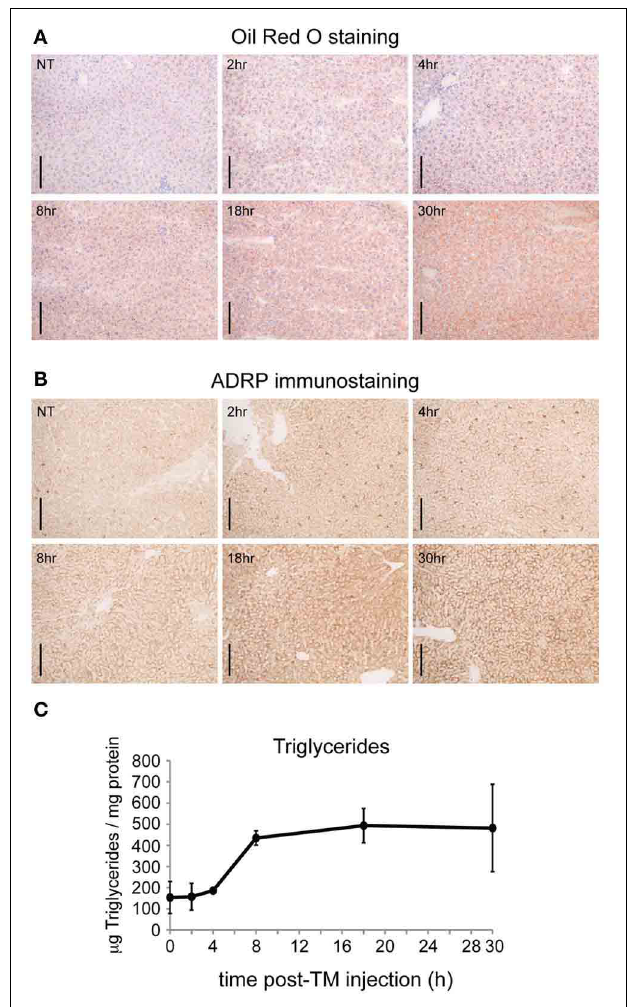
FIGURE 1 | ER stress causes substantial hepatic lipid accumulation within 8h. (A) C57BL/6J mice were challenged with 1mg/kg TM for the indicated times, livers were frozen in OCT, and lipids were stained with Oil Red O. Scale bar = 50 μ m. (B) Same as (A) , except lipid content was assessed by immunohistochemical staining for the lipid droplet marker protein ADRP. Scale bar = 50 μ m. (C) Same as (A) , except triglyceride content was measured by colorimetric assay after extraction of neutral lipids. p < 0 . 001 by One-Way ANOVA. n = 3 samples per time point. Error bars here and elsewhere show means ±